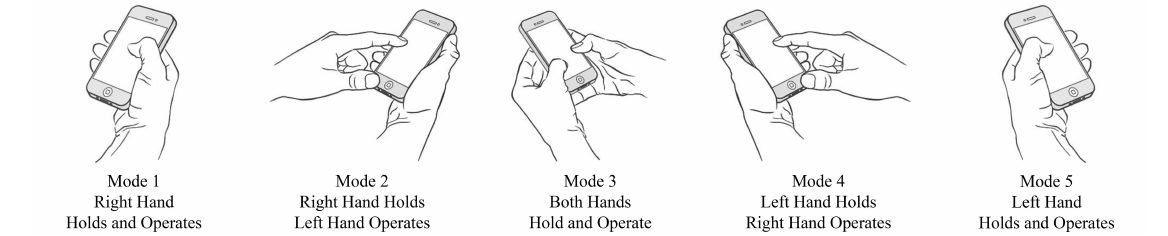
Figure 2. Five smartphone operation